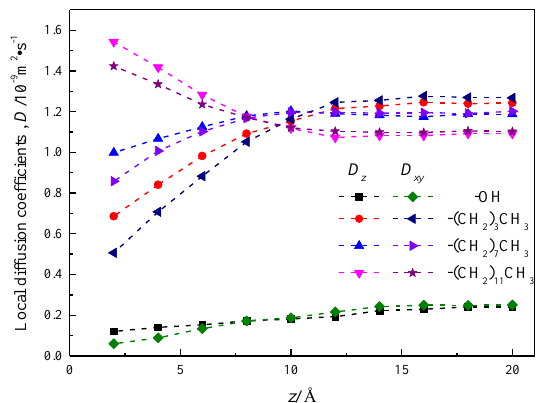
Figure 12. Local diffusion coefficient of water in nanochannel with different surface characteris- tics.